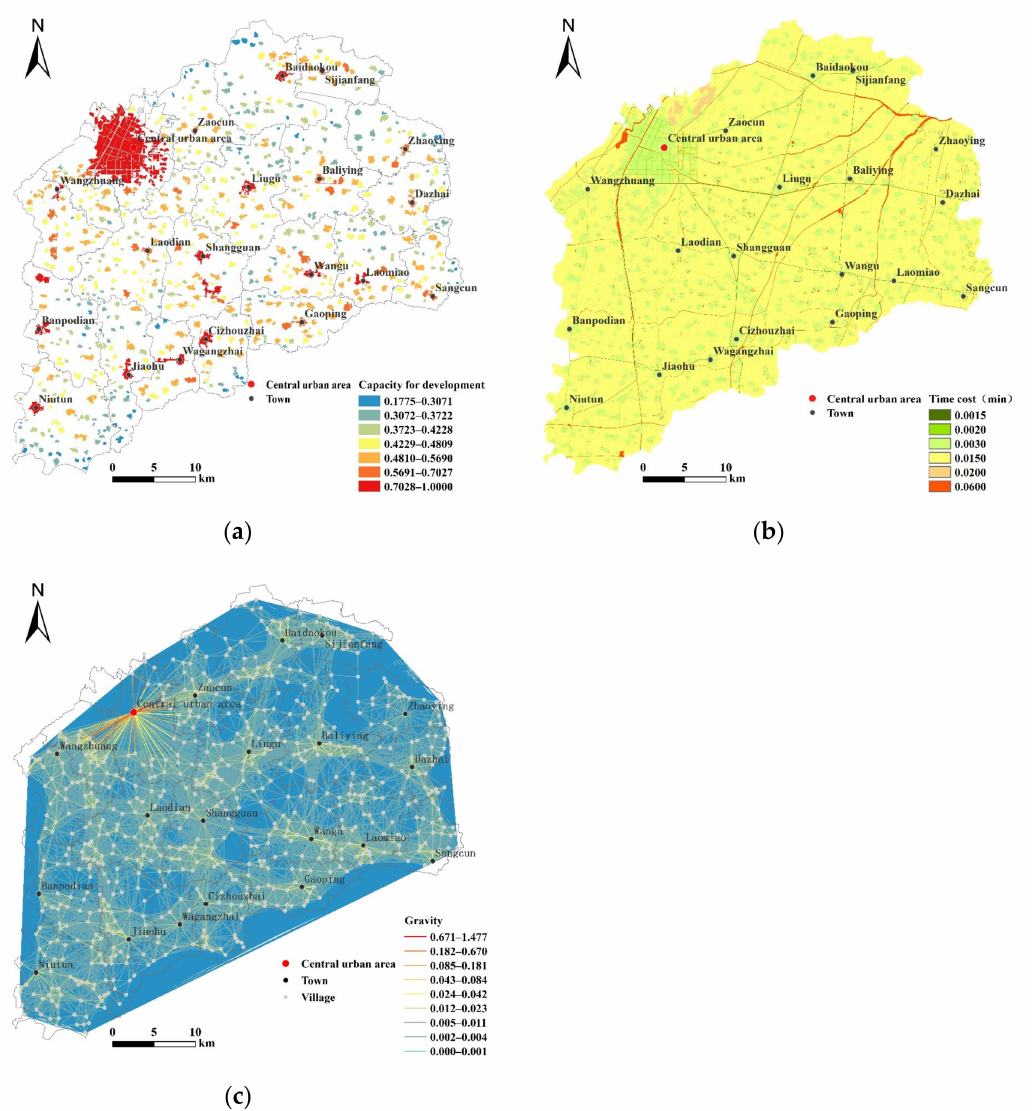
Figure 4. Construction of the spatial interaction network of urban and rural settlements in Hua County: ( a ) Capacity for development of urban and rural settlements; ( b ) Time cost surface; ( c ) Spatial interaction network of urban and rural